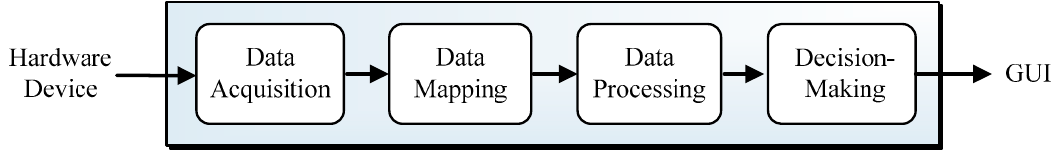
Figure 5. Block diagram of the software application.